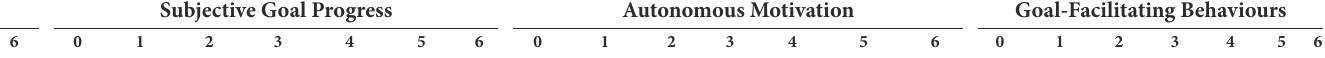
TABLE 2 Correlation matrix of all variables at times